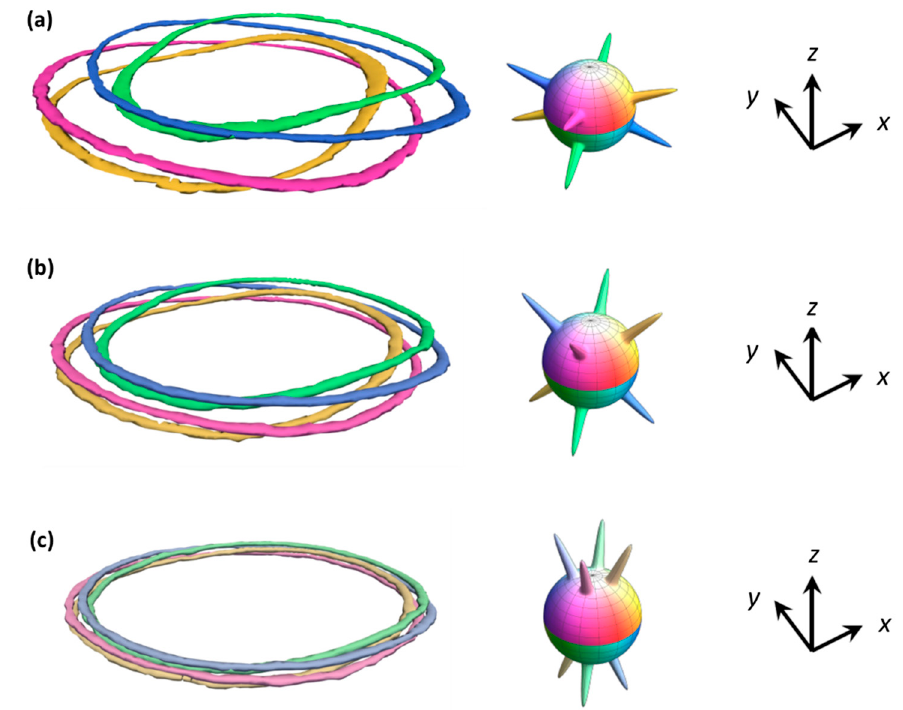
Figure 12. Simulated preimages for configuration 2 (100 µm × 100 µm × 5.5 µm unit, shift of 20 µm between the patterned rings). Each point in the order parameter space RP 2 is encoded with a color of given hue and saturation represented on an S 2 sphere. The bumps on the S 2 spheres represent the direction of the director along each preimage shown on the left. The three sets of preimages ( a – c ) are respectively associated with a polar angle 3 π / 8, π / 4 and π / 8 for the director orientation.